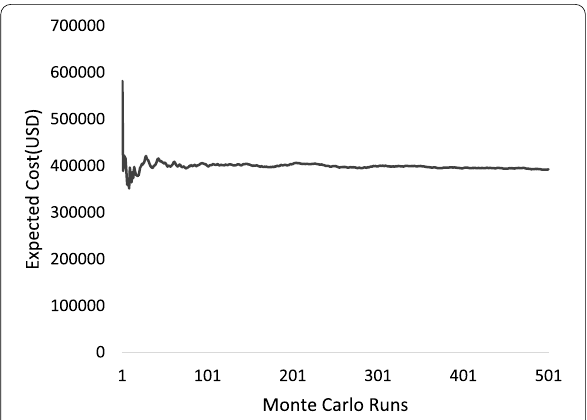
Fig. 7 Convergence study to determine Monte Carlo runs